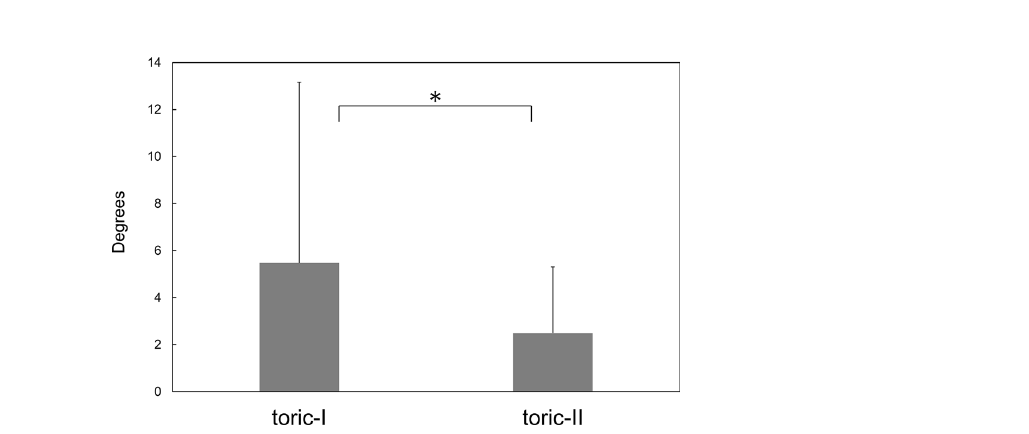
Figure 4. Amount of axis misalignment from the intended axis was significantly smaller with toric-II than with toric-I IOLs (p =